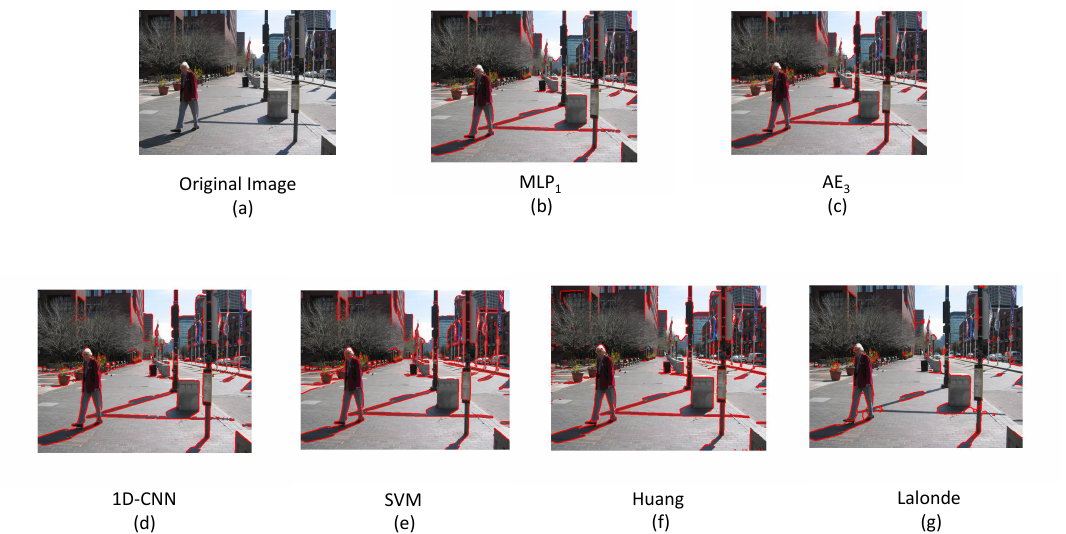
Figure 14. Comparison of shadow detection results achieved by MLP, AE, 1D-CNN, SVM, Huang’s and Lalonde’s classification models on a realistic scene. Note that the best MLP and AE classifiers are reported (i.e., MLP 1 , AE 3